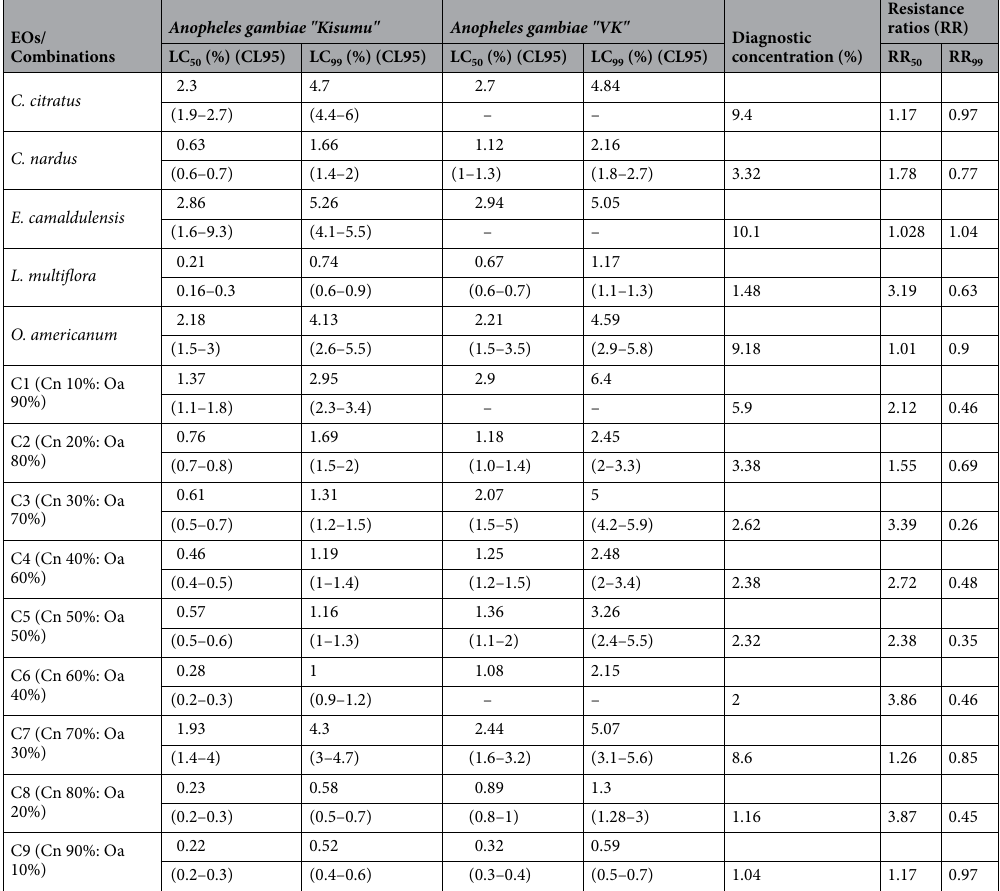
Table 3. LC 50 , LC 99, diagnostic concentration and resistance ratios for all essential oils and combinations of C. nardus and O. americanum tested on Anopheles gambiae populations. LC 50 : lethal concentration for 50% mortality; CL 95= Confidence limit at 95%; Cn : Cymbopogon nardus ; Oa : Ocimum americanum; % : percentage; RR 50 : Resistance ratios with LC 50 ; VK : Vallée du